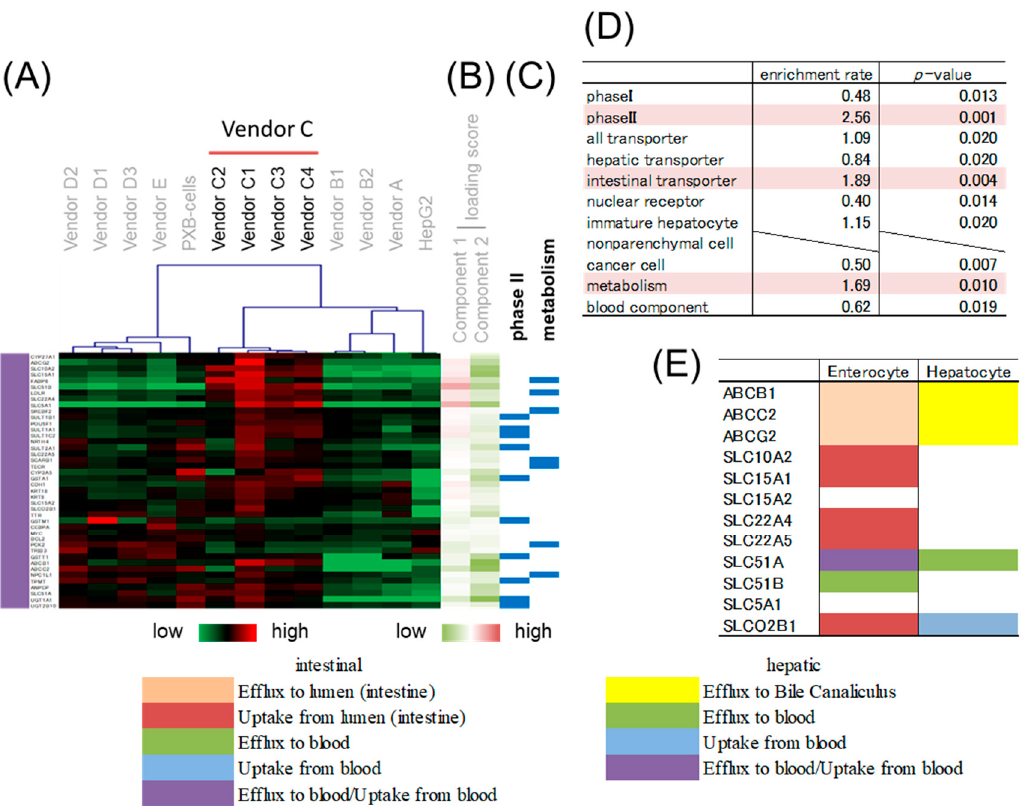
Figure 8. Enrichment analysis of the purple branch. ( A ) Heatmap patterns. ( B ) PC 1 and 2 scores. Red lines exhibit plus scores, and green lines exhibit minus scores. ( C ) The blue lines exhibit genes related to drug metabolism phase II enzymes. ( D ) Enrichment rates and p -values from the chi-squared test of different gene categories. The highlighted categories are significantly enriched. ( E ) Transporter genes. Hepatic and intestinal transporter genes are classified according to function, as shown by color.